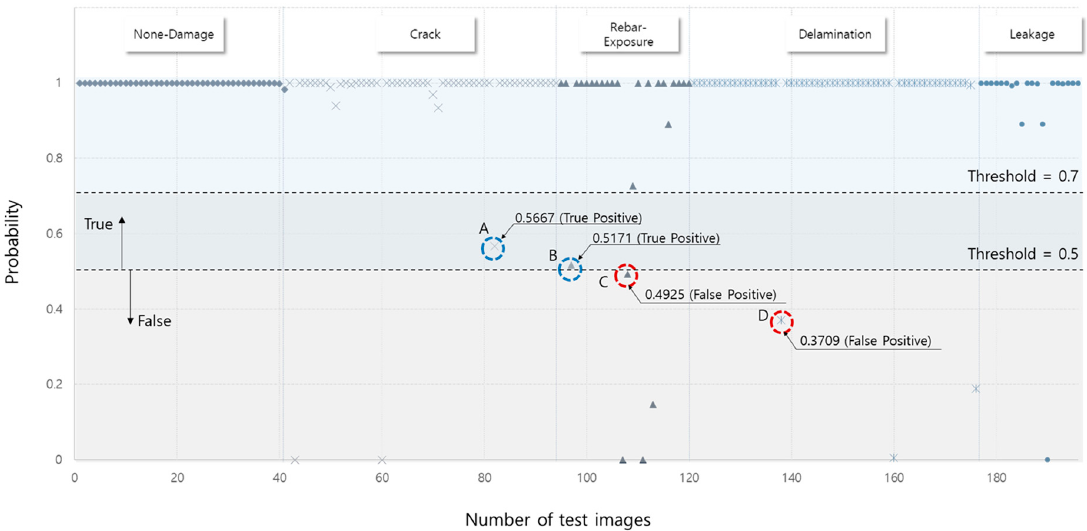
Figure 7. Prediction probability distribution with cut point located at 0.7; results A and B were found to be false positive but were determined to be true positive in model-performance evaluation.